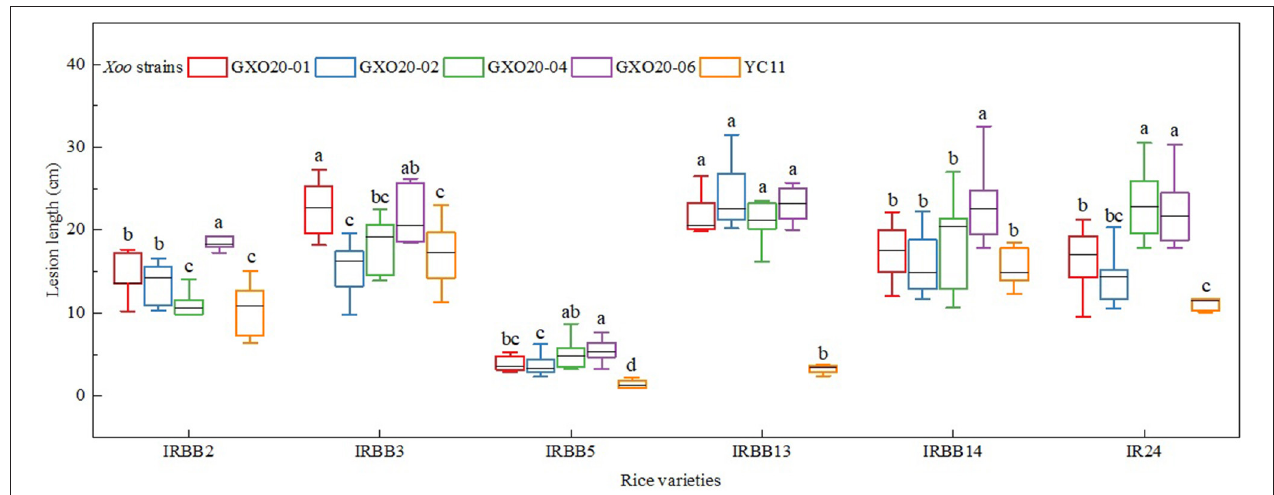
FIGURE 1 | Responses of disease of newly isolated Xoo strains test on IRBB NILs. The least significant difference (LSD) test was used for data analysis at P < 0.05 level, showing as lowercase letters.